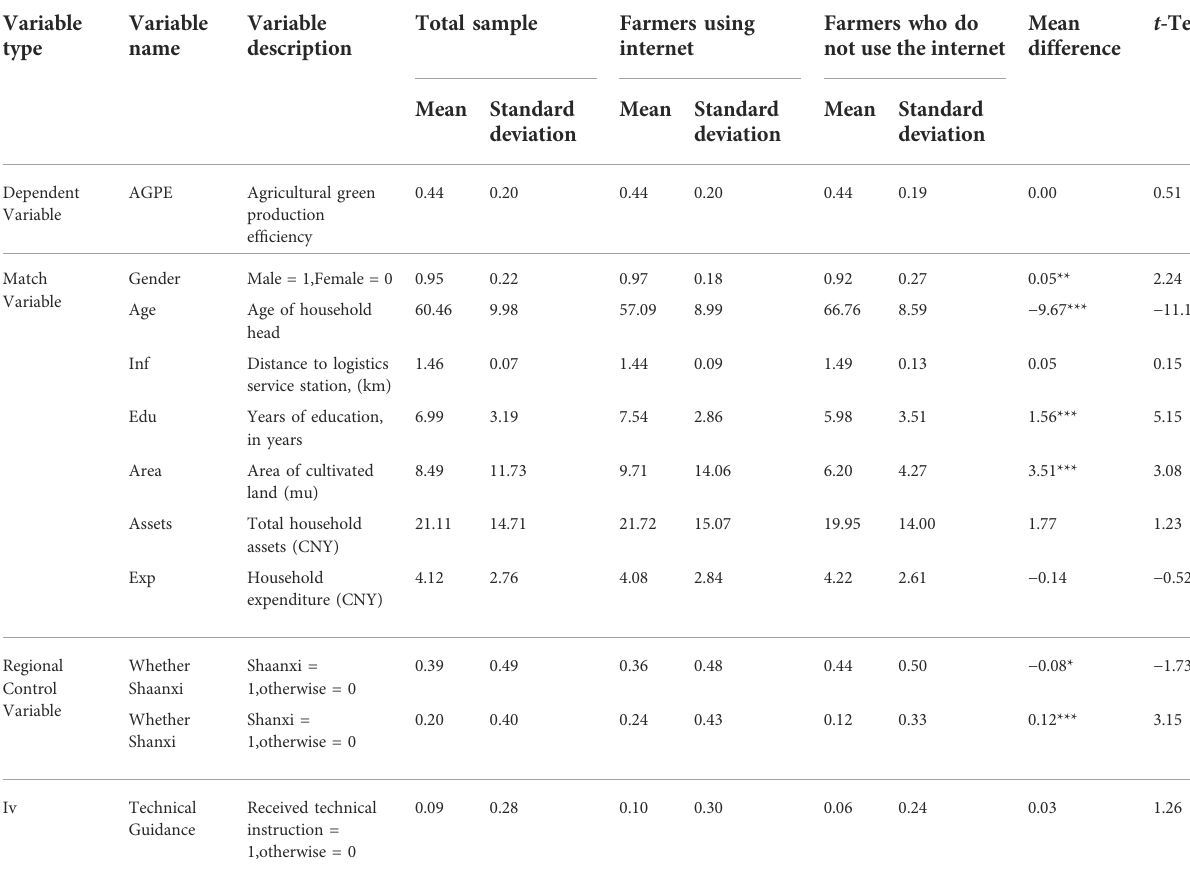
TABLE 1 Descriptive statistics of farmers who use the internet and those who do not